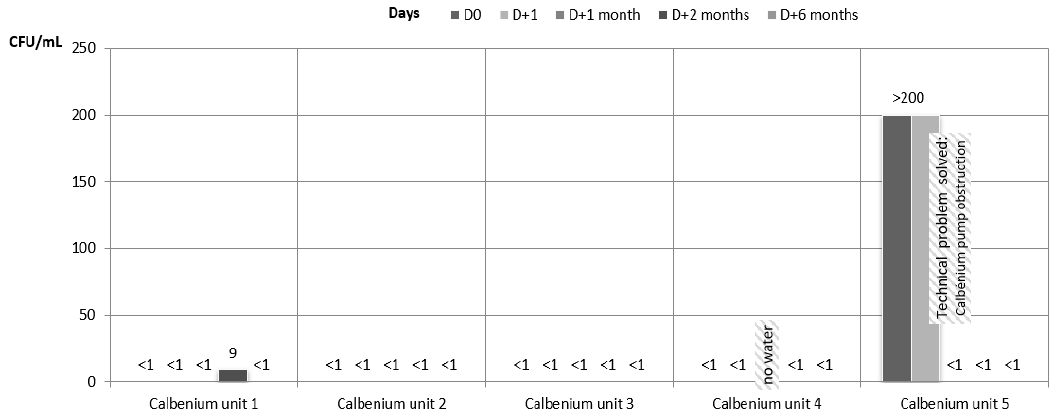
Figure 4. Microbiological quality of the water samples for the units connected to the IGN Calbenium ® system. HPC at 37 ◦ C.